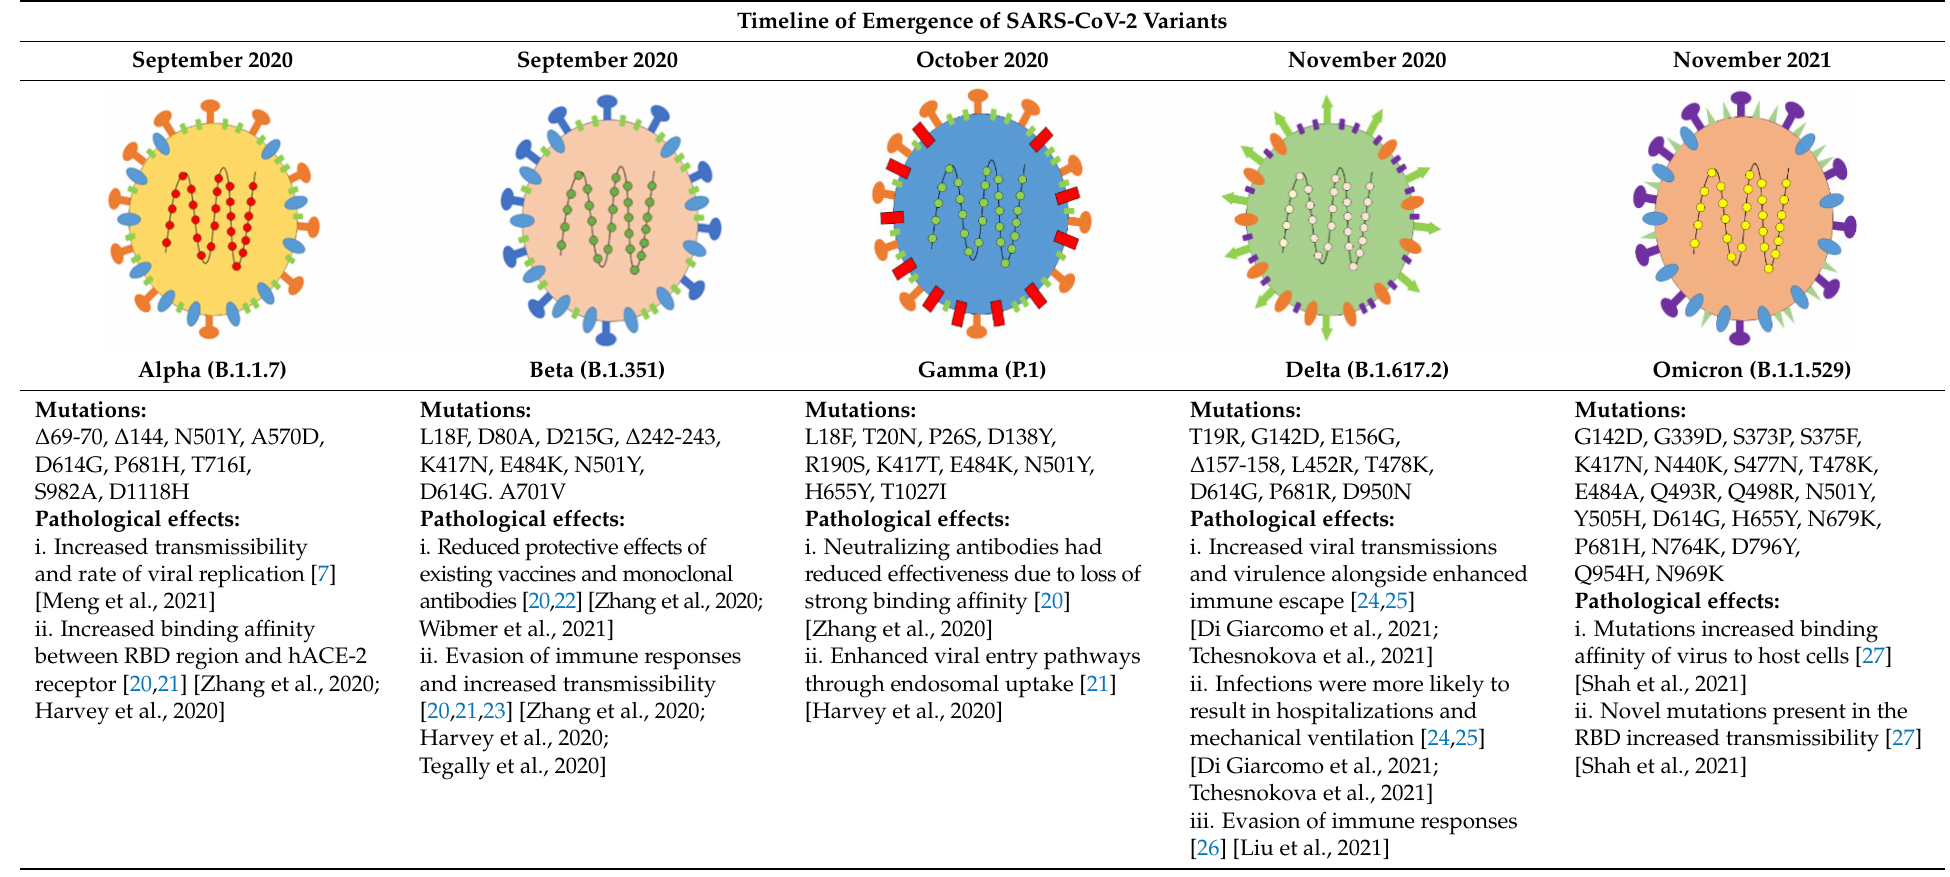
Table 1. Timeline of emergence of SARS-CoV-2 variants and mutations present in Alpha. Beta, Gamma, Delta and Omicron variants in the viral spike (S) gene. Timeline of Emergence of SARS-CoV-2